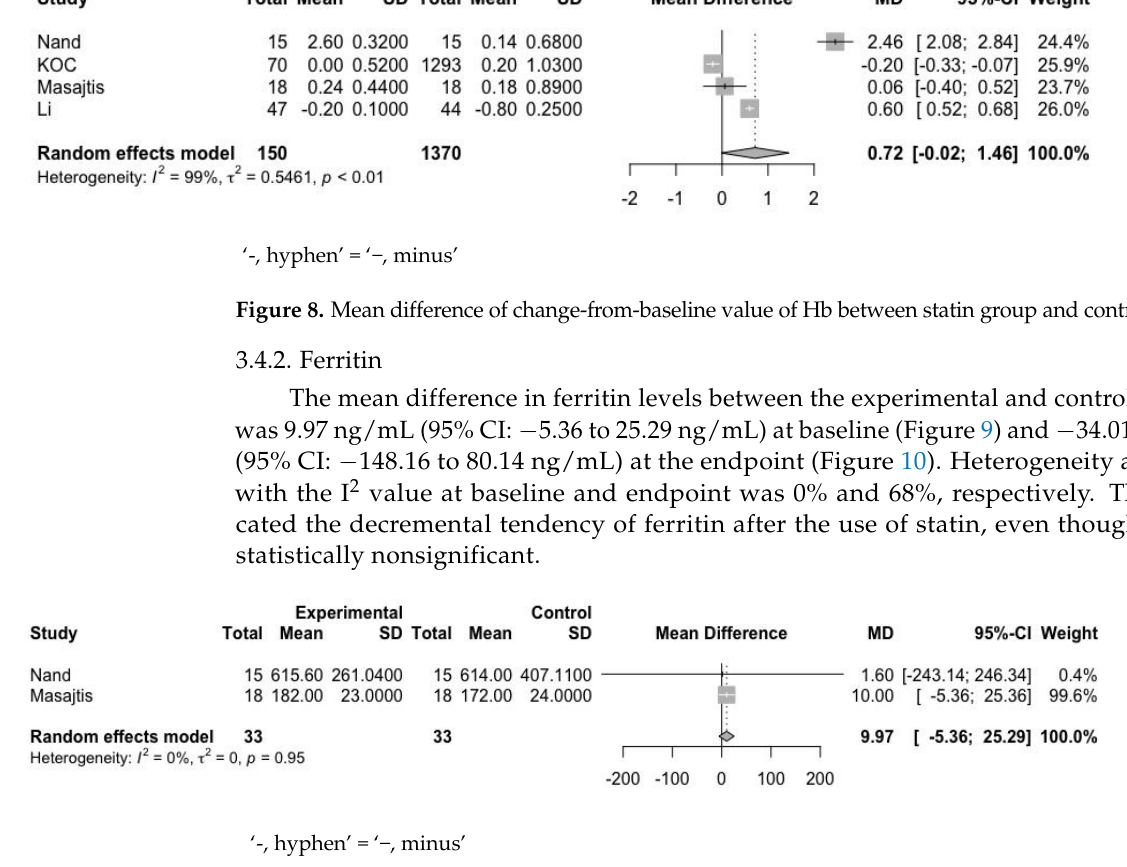
Figure 9. Mean difference of ferritin between experimental group and control group at baseline.